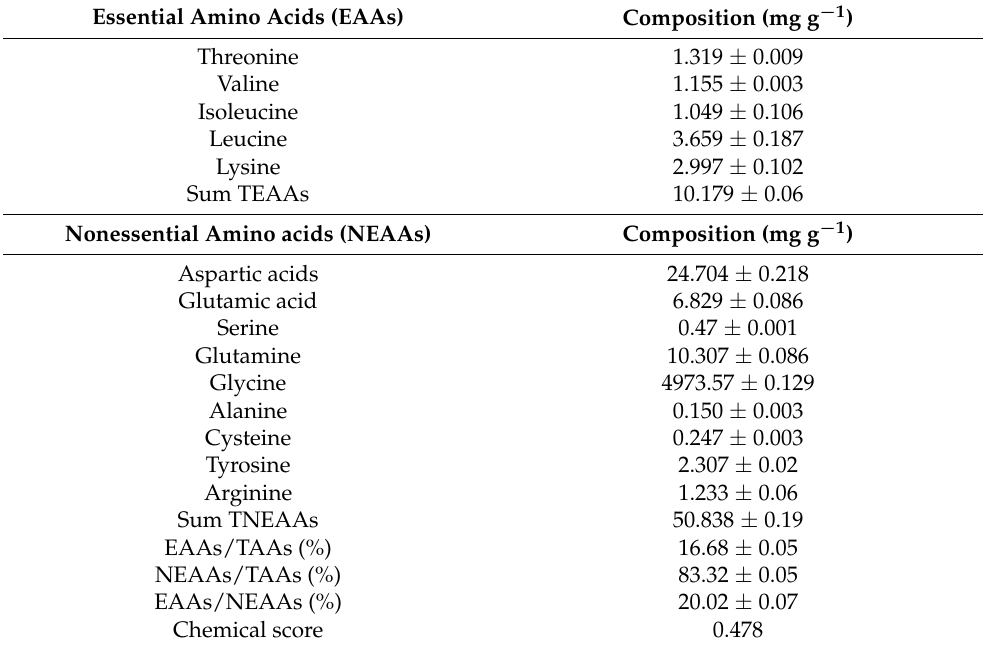
Table 2. Amino acid composition in the brown algae P. tetrastromatica ( n = 3). Essential Amino Acids